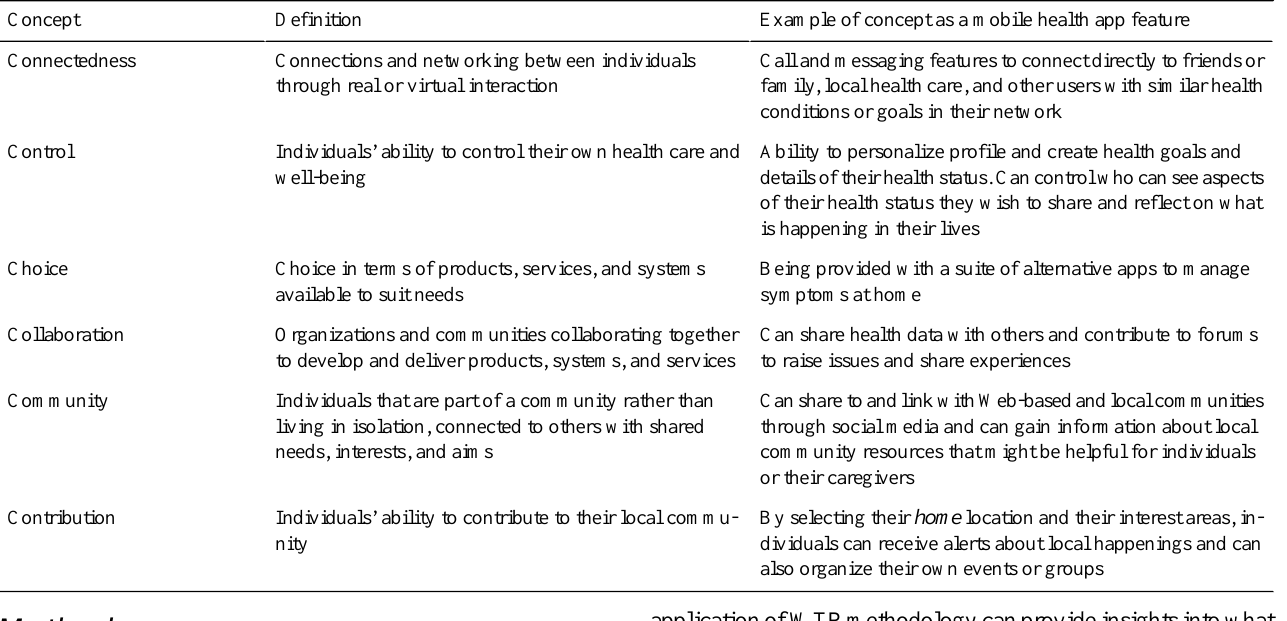
Table 1. Innovate UK